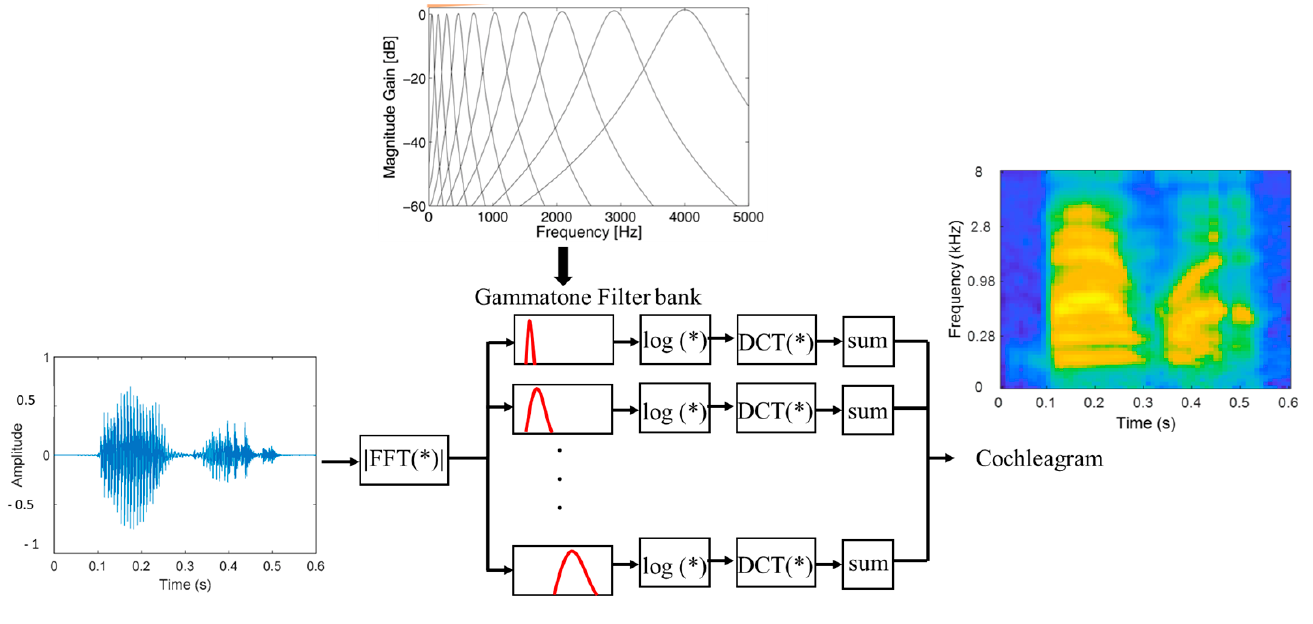
Figure 6. Cochleagram operation.